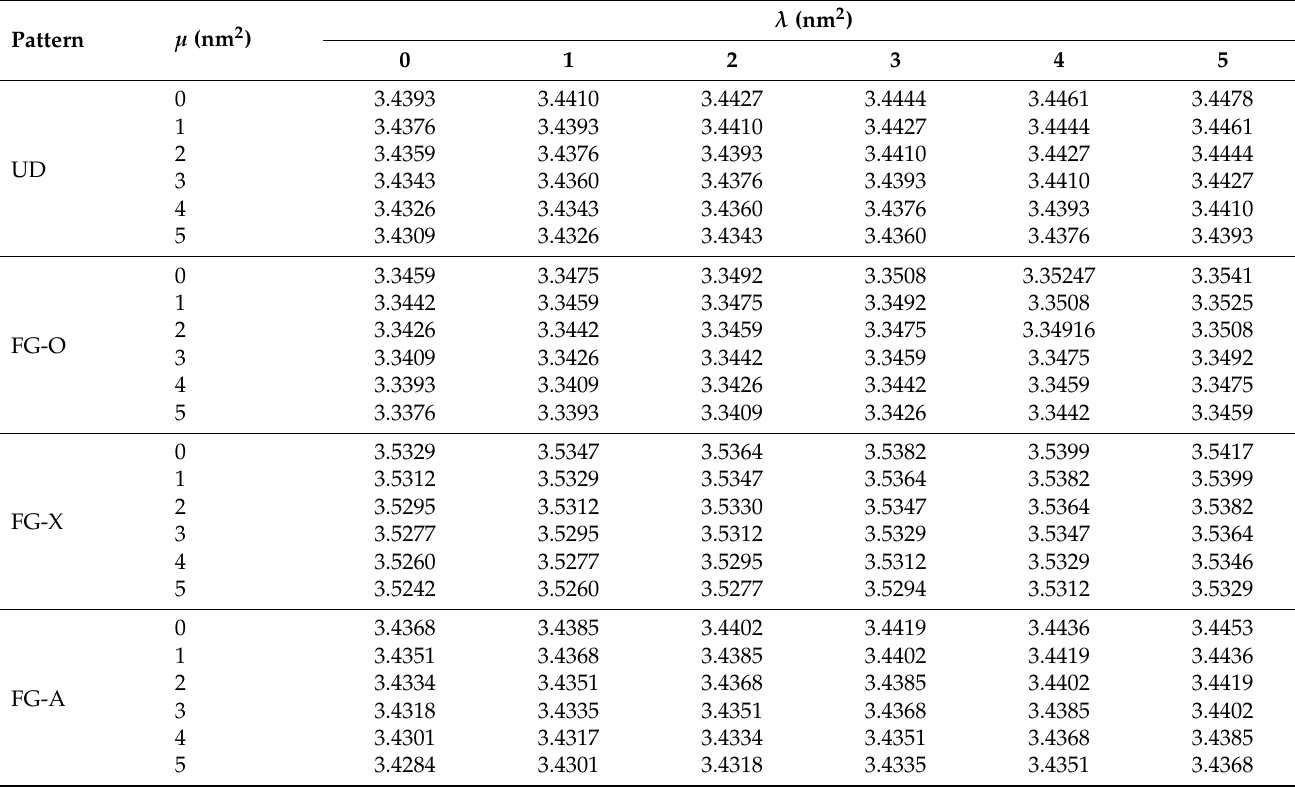
Table 7. Effect of nonlocal and small-scale parameters on dimensionless critical buckling load of GRC